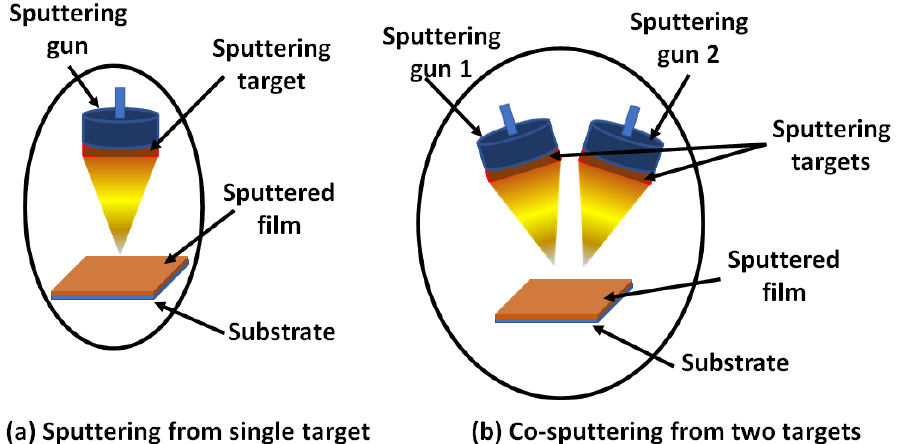
Figure 1. Schematic diagram of RF magnetron sputtering and co-sputtering techniques used for garnet and composite layers fabrication. garnet and composite layers